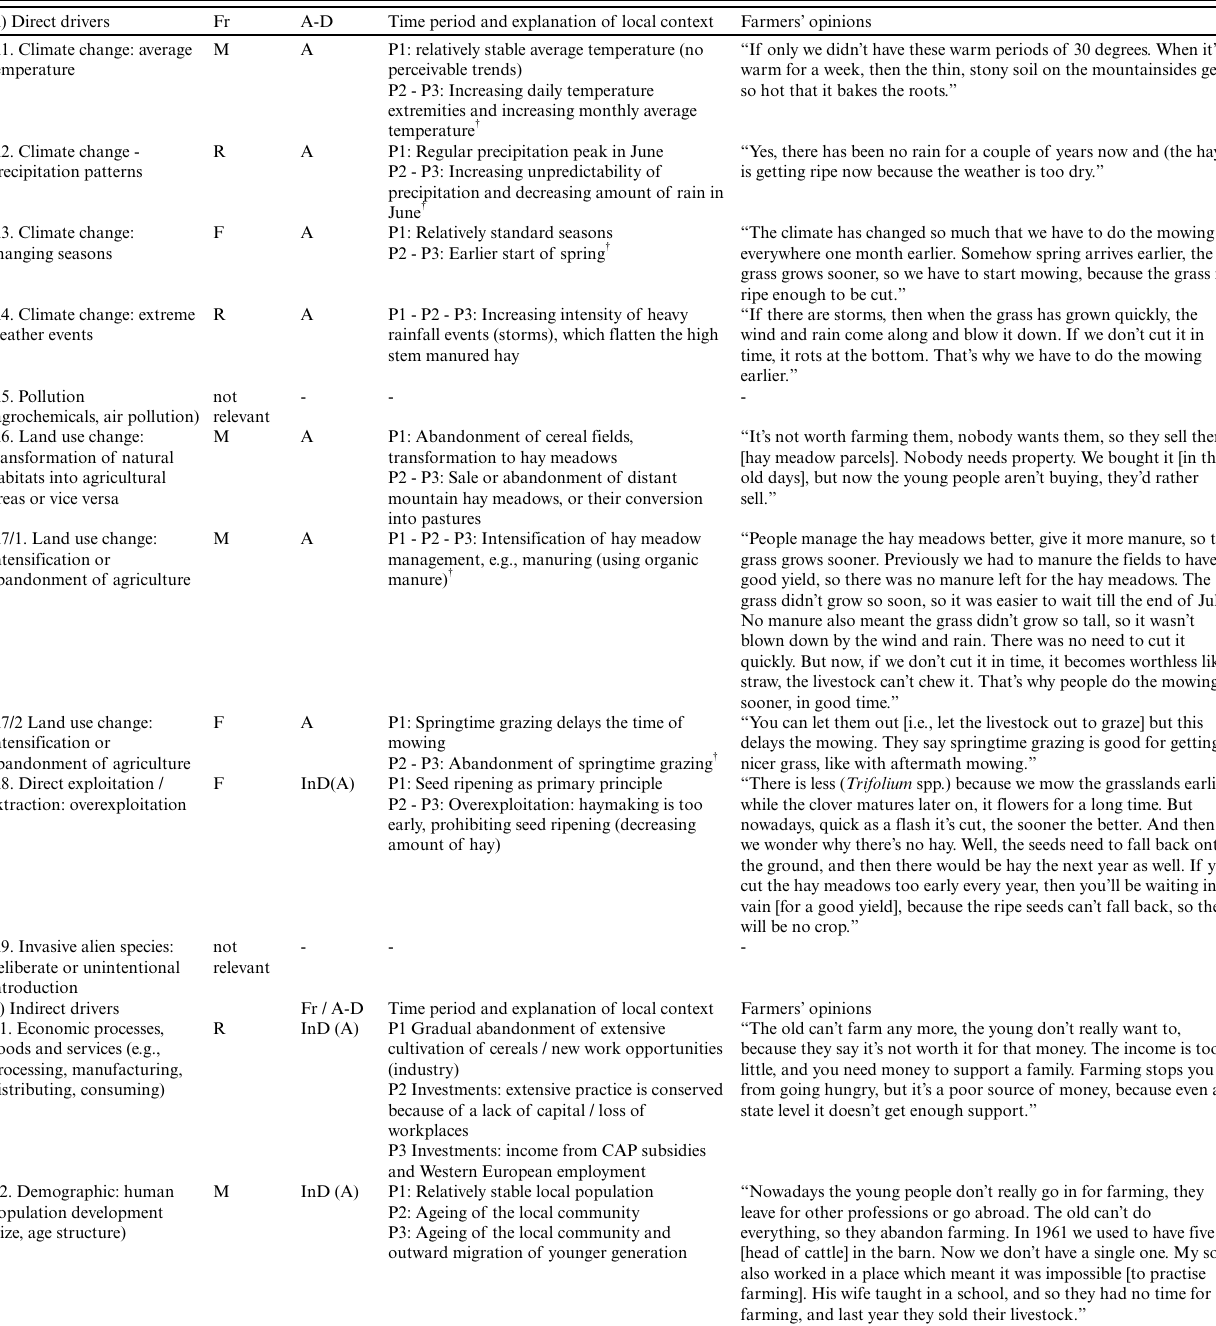
Table 2 . Direct and indirect drivers in Gyimes (driver categories are based on Elbakidze et al. 2018). Time periods: P1: 1950–1990, P2: 1990–2007, P3: 2007–2019. Daggers † indicate drivers that directly affect the ripening of the vegetation. Other drivers influence further elements of the social-ecological system affecting the time of mowing. Frequency (frequency of mentions): F: frequently mentioned, M: mentioned to a medium extent, R: rarely mentioned. Impact of the drivers: advances (A) or delays (D) the time of mowing; indirectly impacting drivers